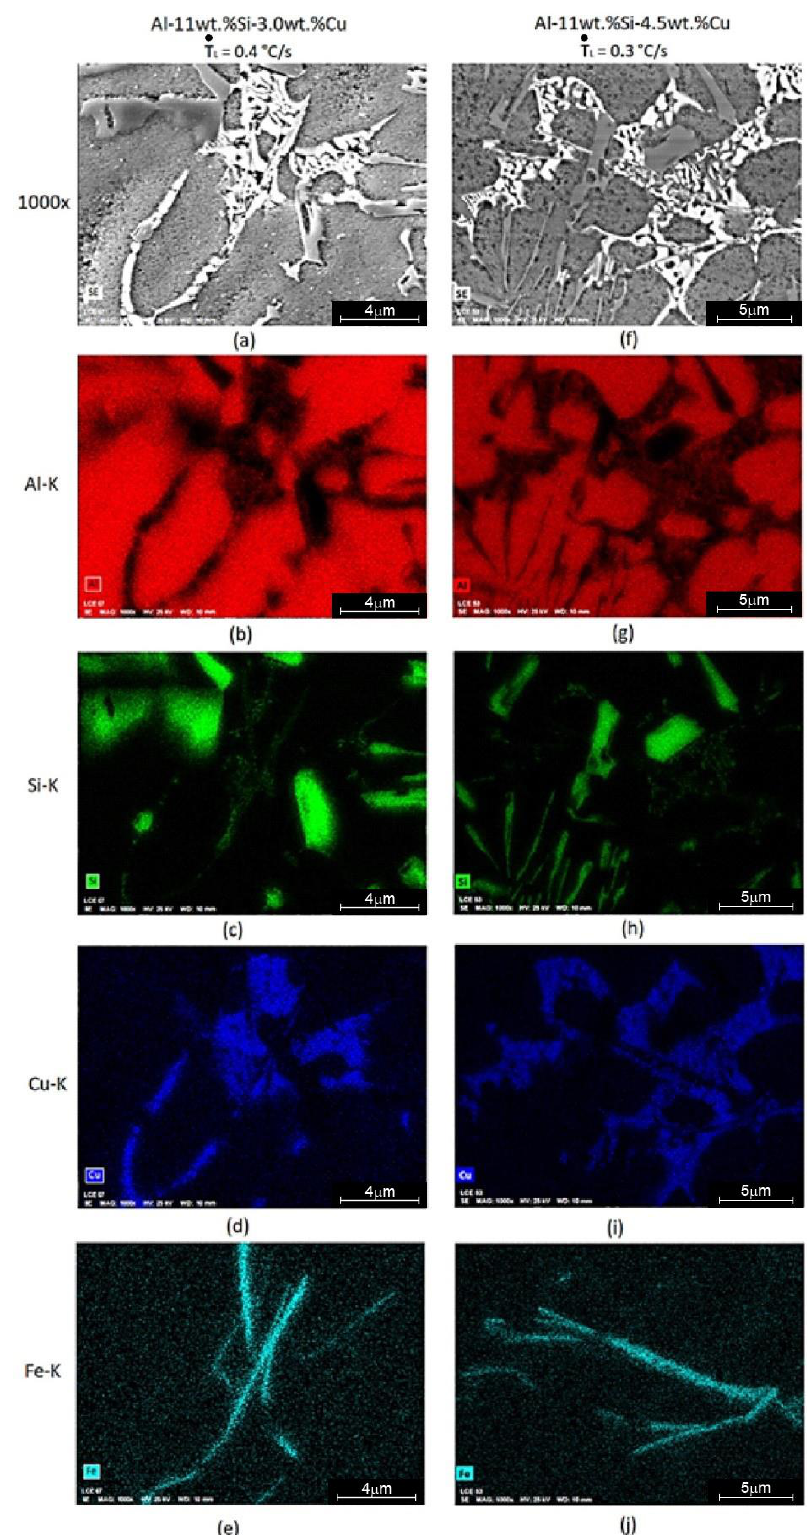
Figure 14. SEM images in the SE signal of the ( a , f ) Al–Si–Cu alloy samples along the casting length at different positions from the cooled bottom surface, and respective X-ray elemental mappings through energy dispersive X-ray spectrometry (EDS): Al–K ( b , g ), Si–K ( c , h ), Cu–K ( d , i ) and Fe–K ( e , j ).